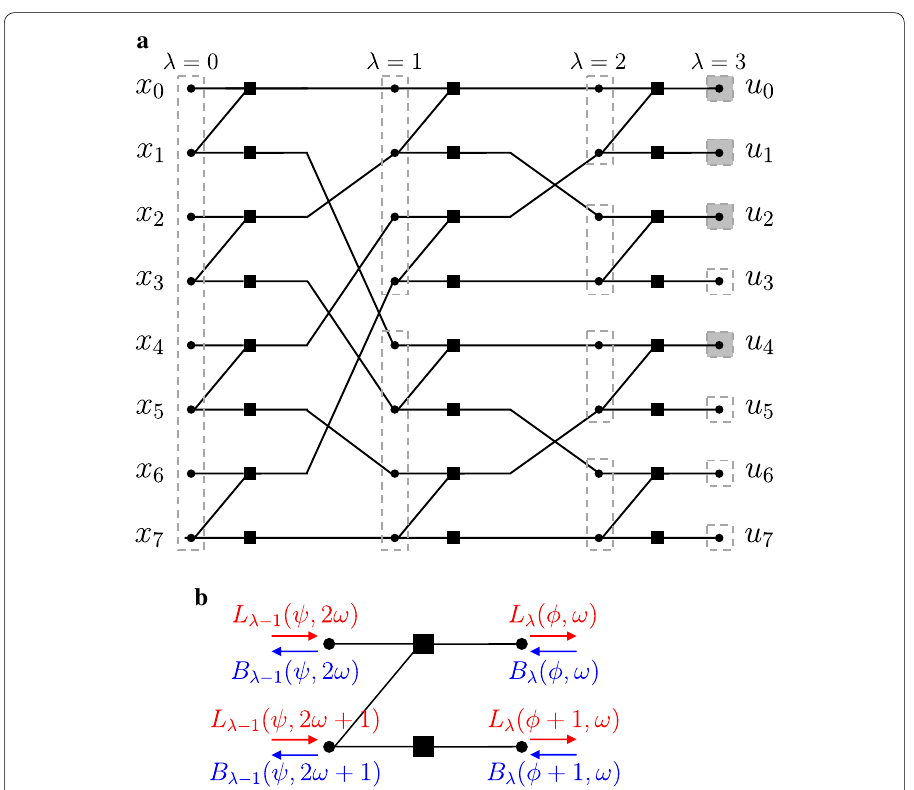
8 . b Protograph of a polar code where ψ =